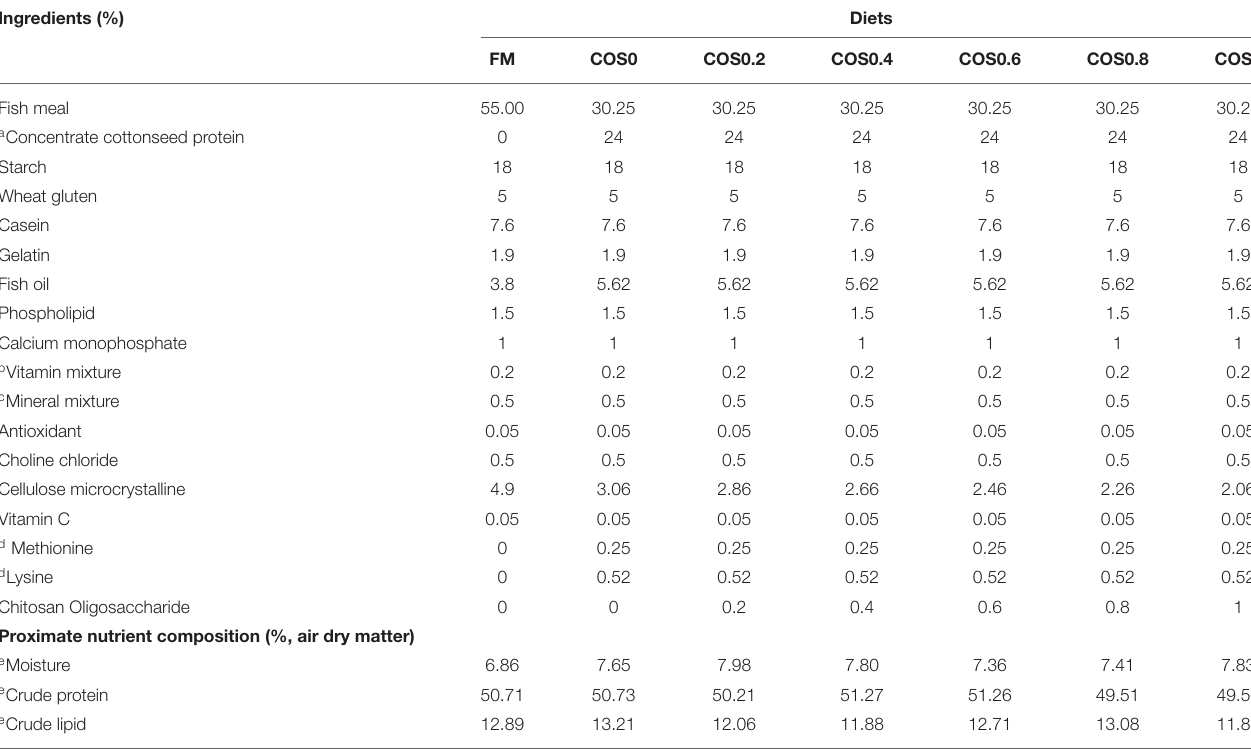
TABLE 1 | Ingredients and proximate nutrient composition of test diets for hybrid grouper. Ingredients